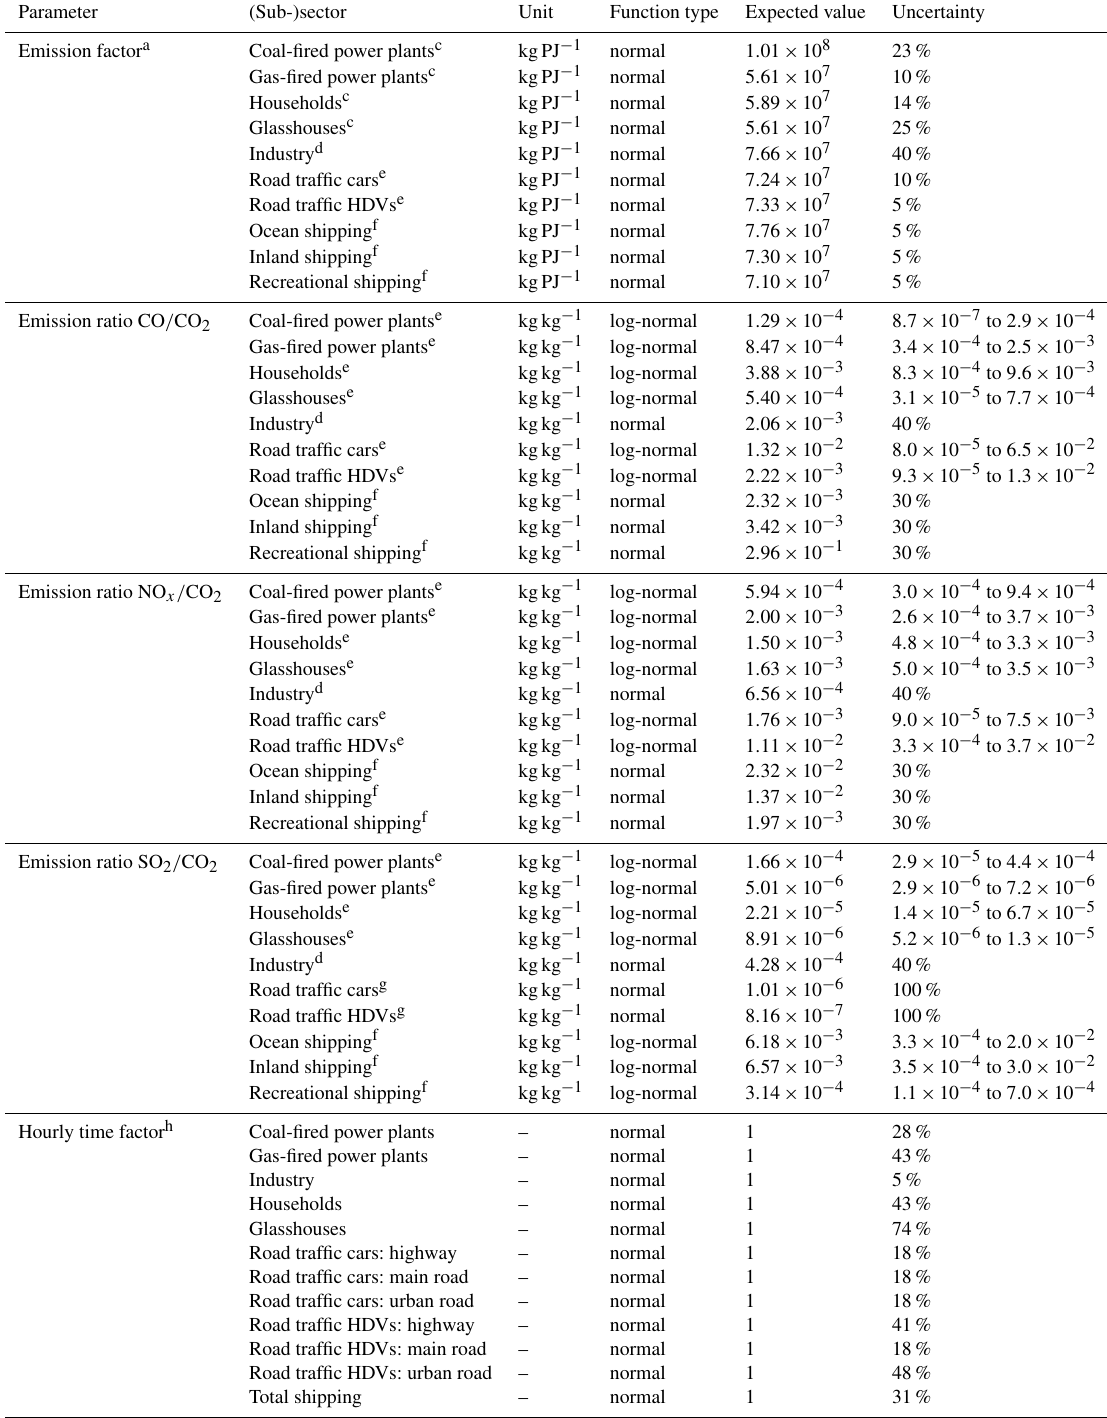
Table A1. Overview of all parameters in the dynamic emission model, their unit, function type, expected value, and uncertainty (range).